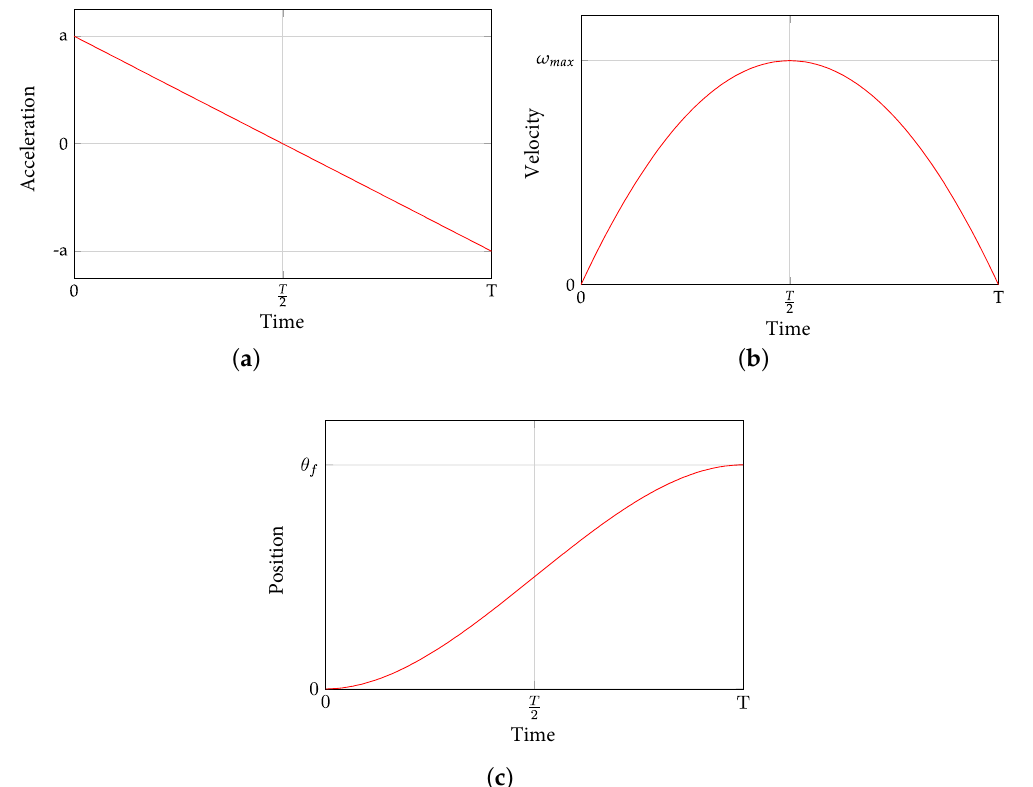
Figure 1. Curves obtained for the parabolic profile: ( a ) Acceleration, ( b ) Velocity, ( c )